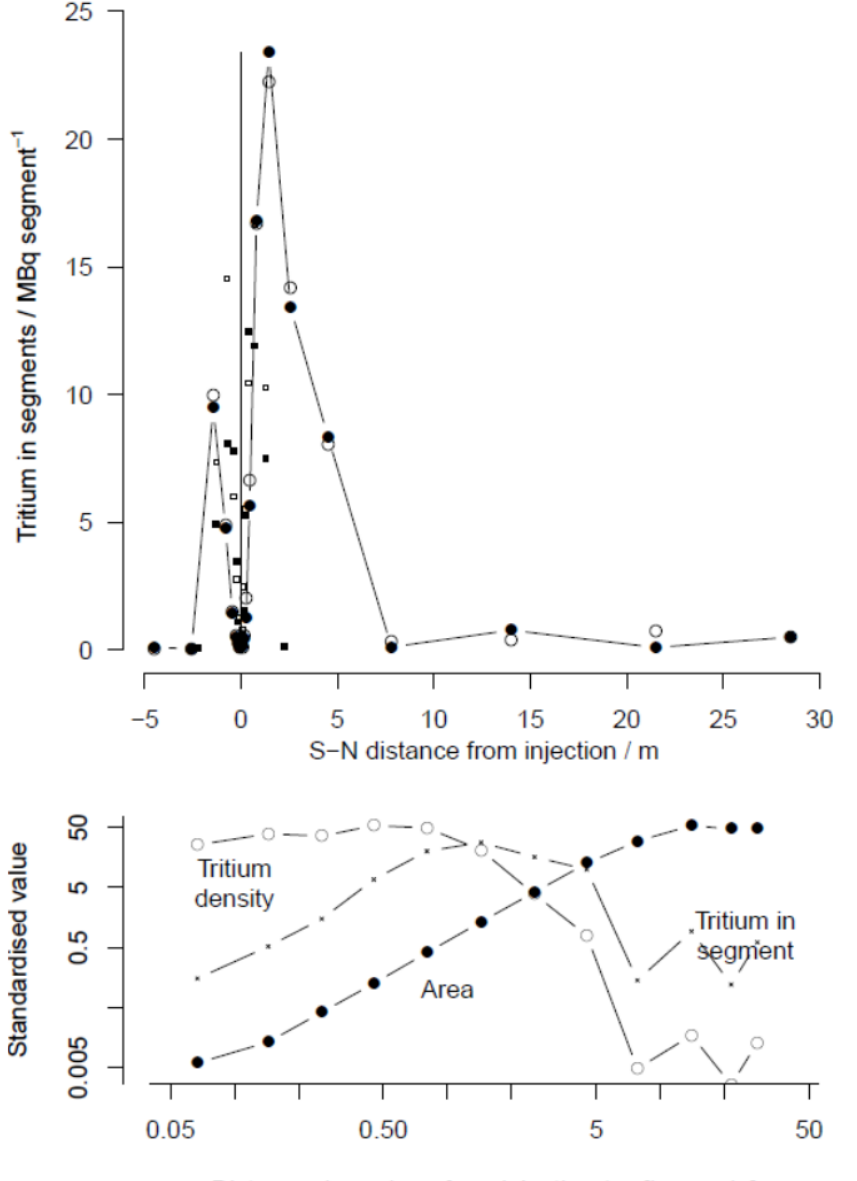
Figure 11. Upper: for injection site A. Total tritium from S to N in trapezoidal segments of shells around the injection site. The total for each segment is the mean activity for its four defining corners multiplied by the segment area. Circles are for segments with axis E–W; (smaller) squares for S–N oriented segments. The further from the injection site, the larger the trapezium. Filled symbols are for trapezia to the E of the injection site, and are also connected by lines; open symbols to the W of the injection site. S–N distances are to the centre of gravity of the trapezium. Lower: for the two western (W) trapezia oriented along the contour (represented by open circles in the upper graph), and for the downslope direction (to the N) only, plotted on double log scales. Unfilled circles ‘Tritium density’ (concentration, as in Figure 10), filled circles ‘Area’ of trapeziodal segment, small crosses ‘Tritium in segment’ (product of the other two lines). The values have been standardised to allow comparison of shapes. Note how, at the right (a long way from the injection site), a tiny difference in ‘Tritium density’ has a large effect on ‘Tritium in segment’, because the ‘Area’ of the trapezium is so